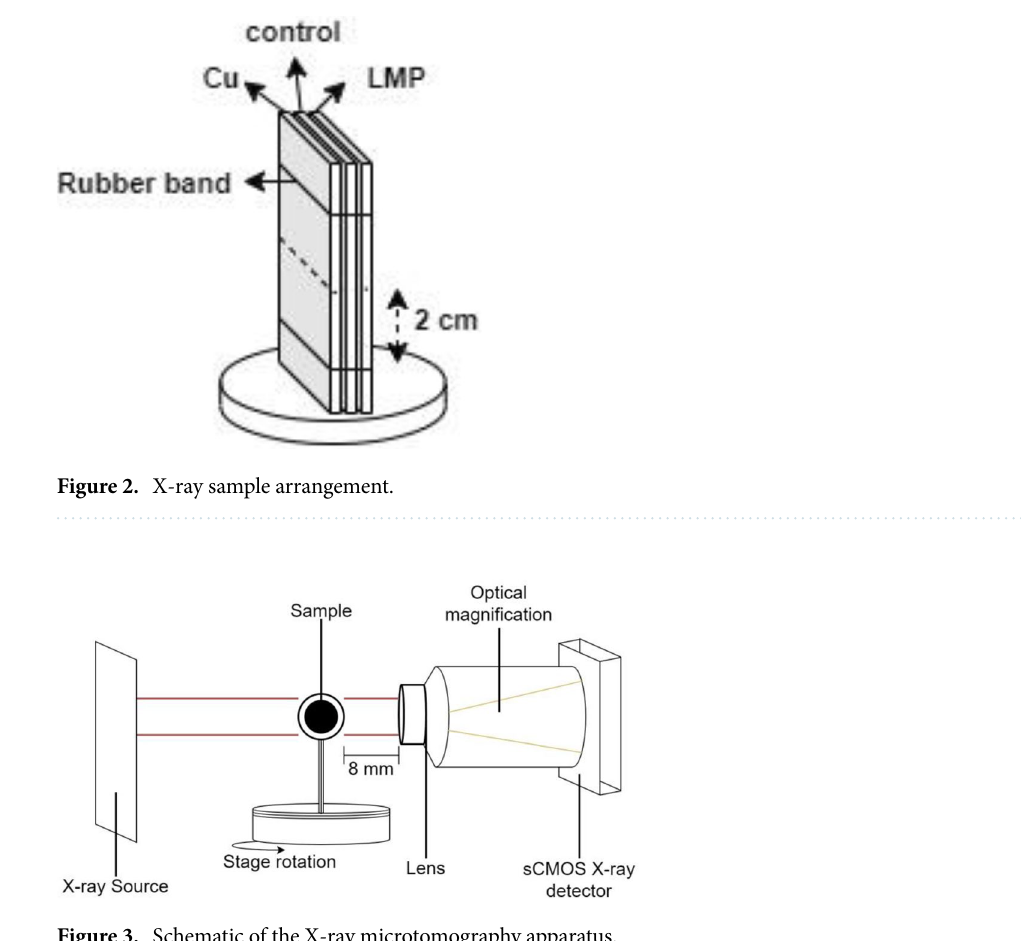
Figure 3. Schematic of the X-ray microtomography